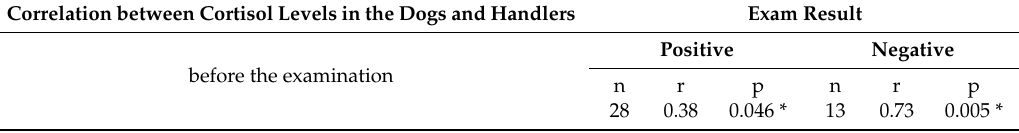
Table 5. Pearson’s linear correlation coe ffi cient r between cortisol levels before the examination with reference to exam results.